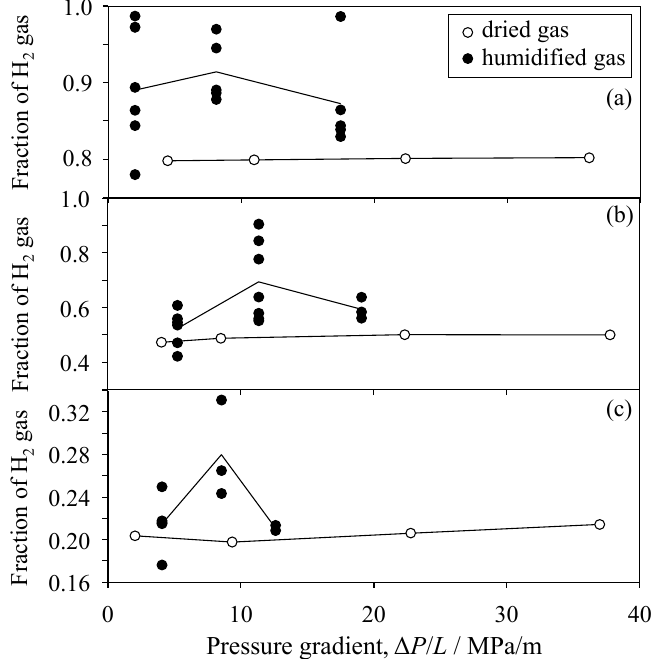
Figure 21. Influence of humidification of supplied gas of ( a ) 80 vol % H 2 –20 vol % CO 2 ; ( b ) 50 vol % H 2 –50 vol % CO 2 and ( c ) 20 vol % H 2 –80 vol % CO 2 on the H 2 fractions through the porous Al 2 O 3 ceramics (60.9% relative density, sample No. 4 in Figure 20).